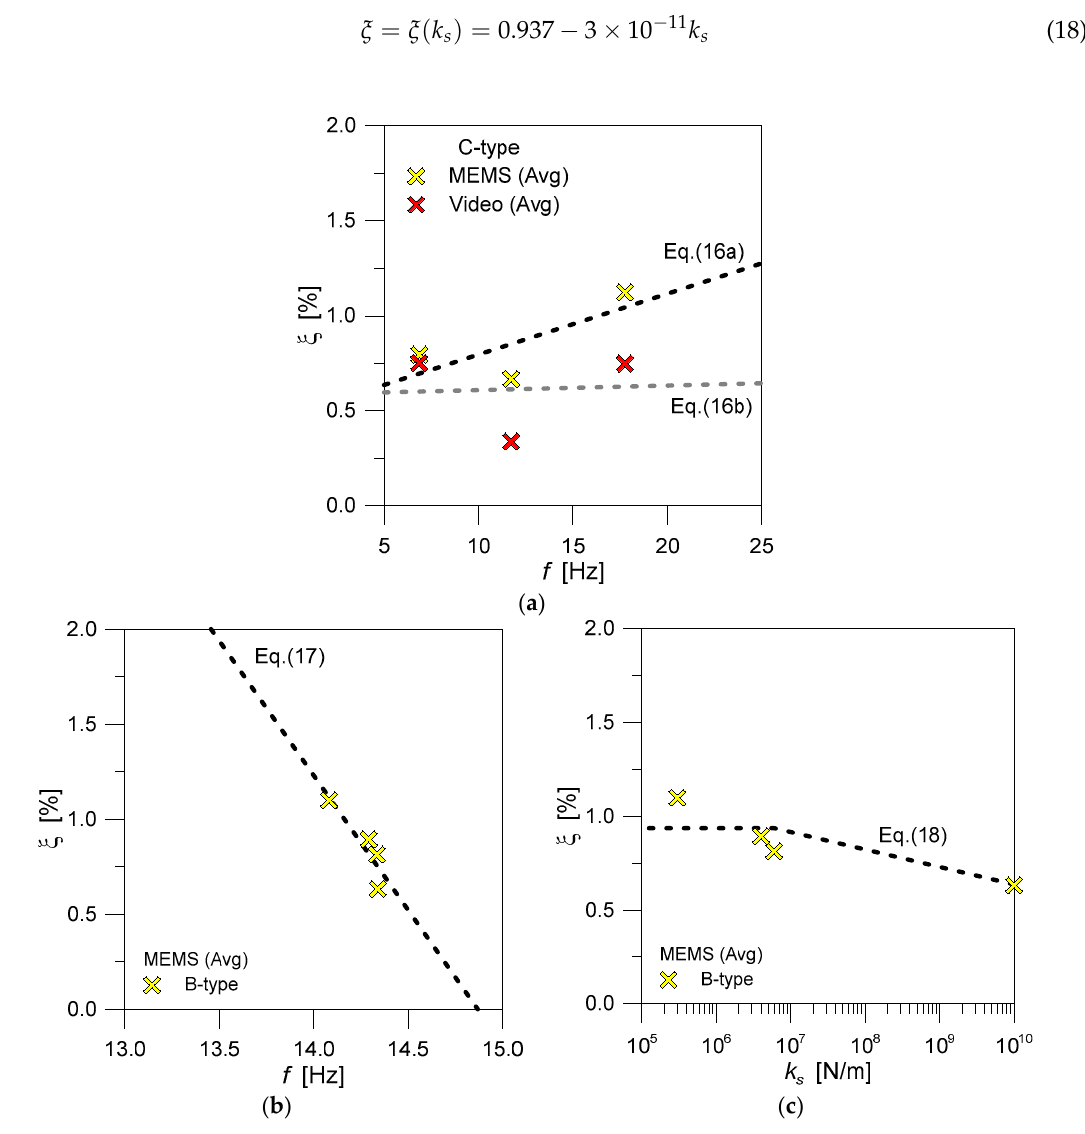
Figure 12. Derivation of analytical fitting curves for the damping estimation of ( a ) cantilever and ( b , c ) beam-like monolithic glass samples.